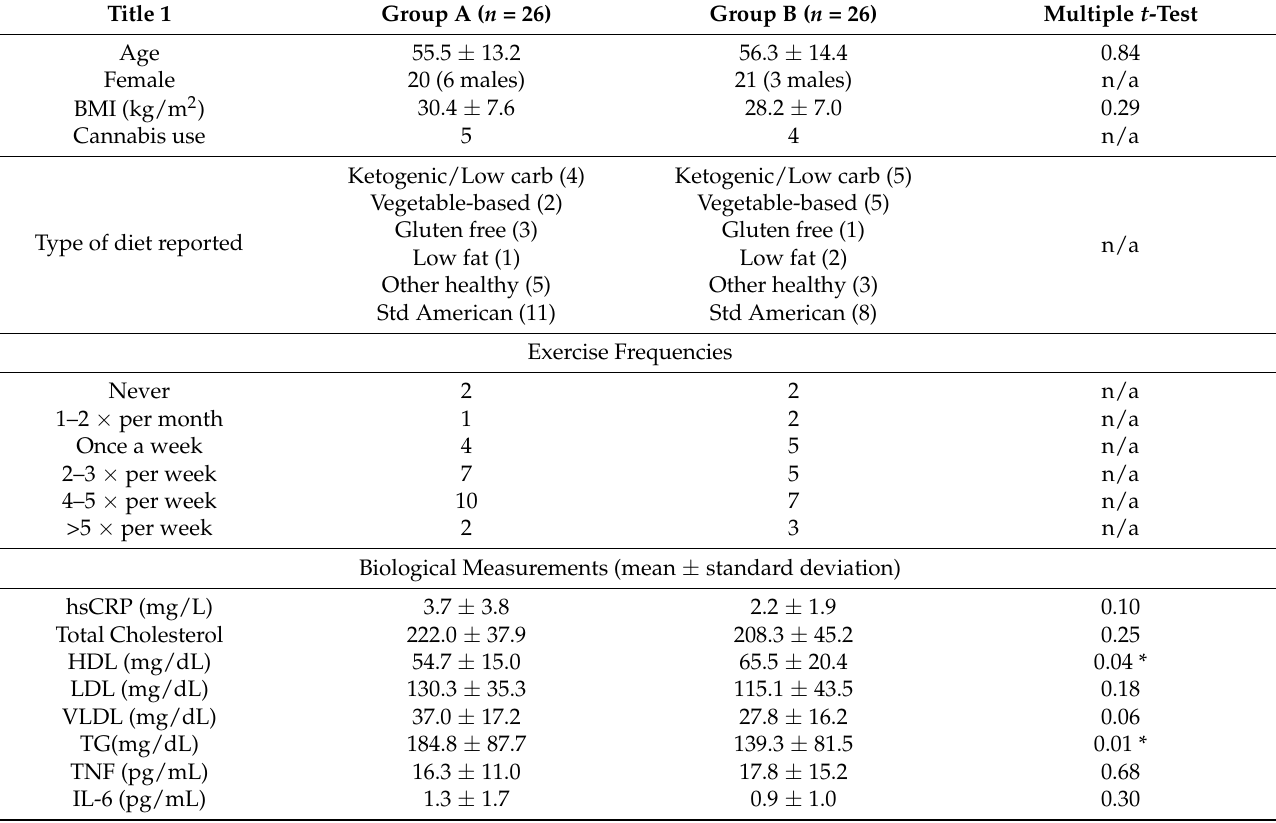
Table 1. General Health Characteristics of Group A and Group B